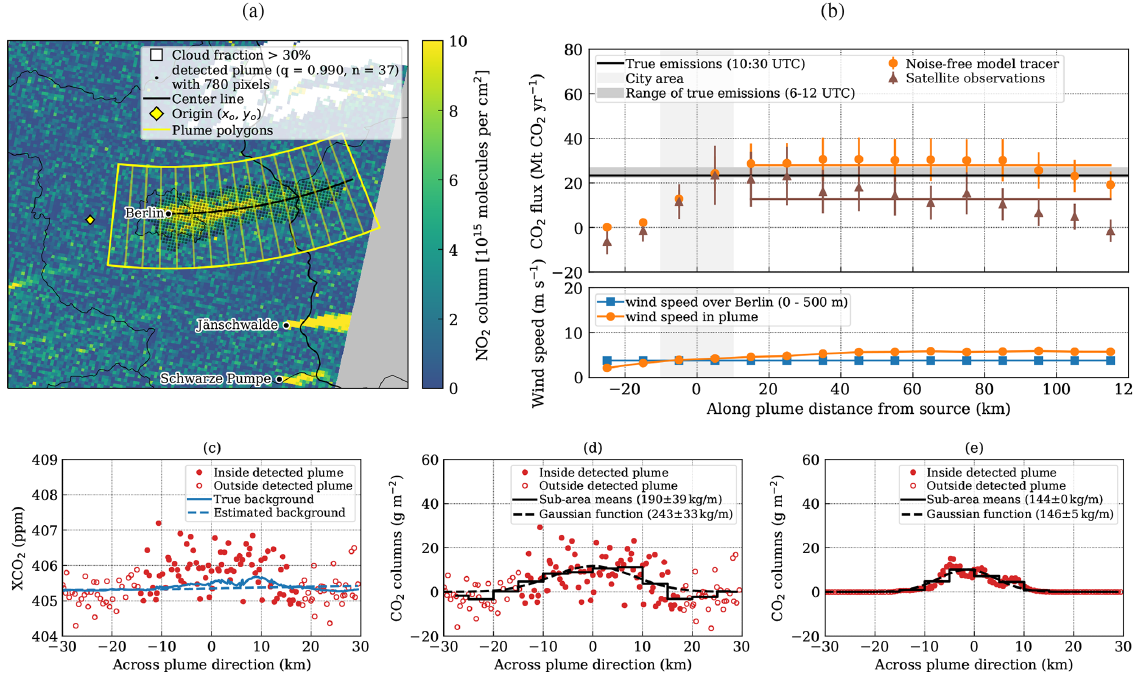
Figure 5. Same as Fig. 4 but using the NO 2 observations for detecting the plume.